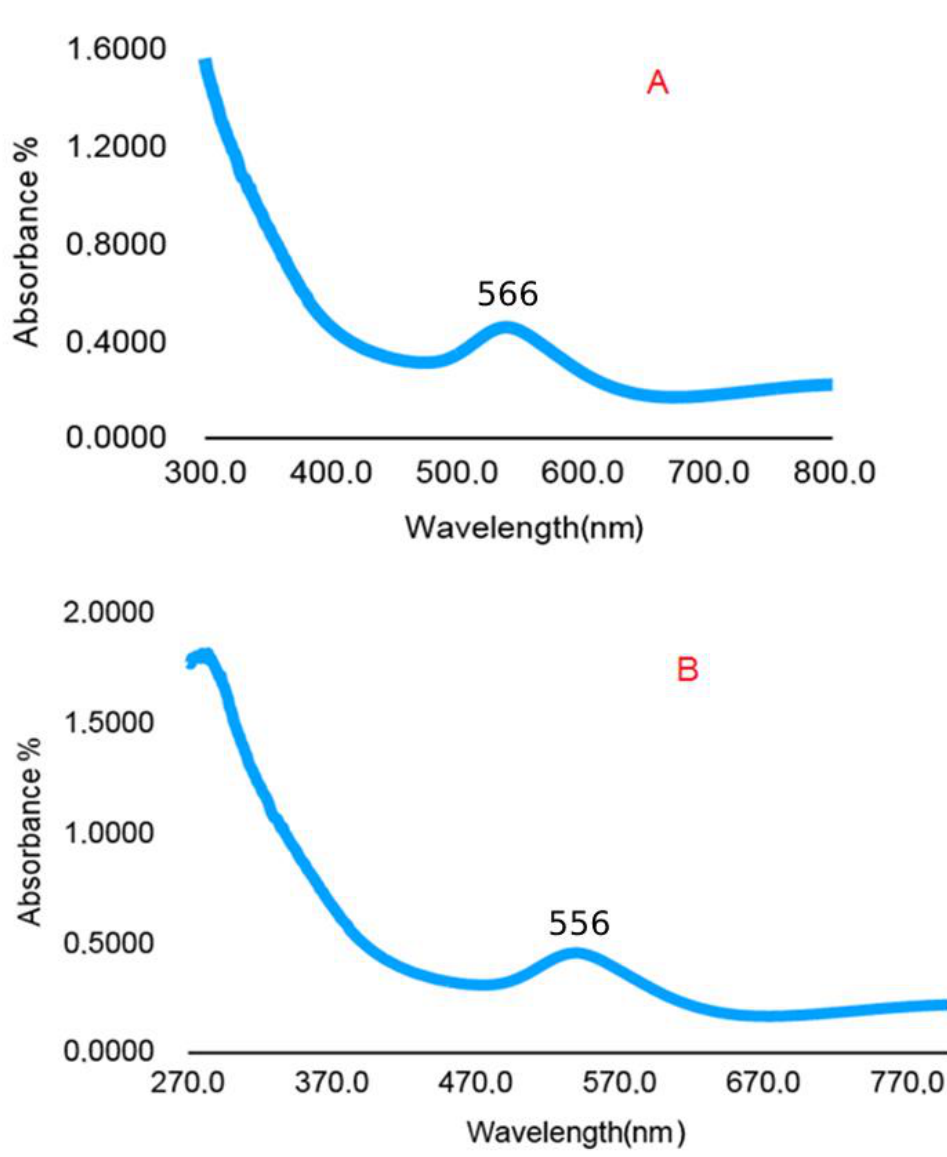
Figure 1. UV–Vis adsorption spectra of AuNFs. ( A ) H-AuNFs absorbance picks from 566 nm; and ( B ) R-AuNFs absorbance picks from 556 nm.